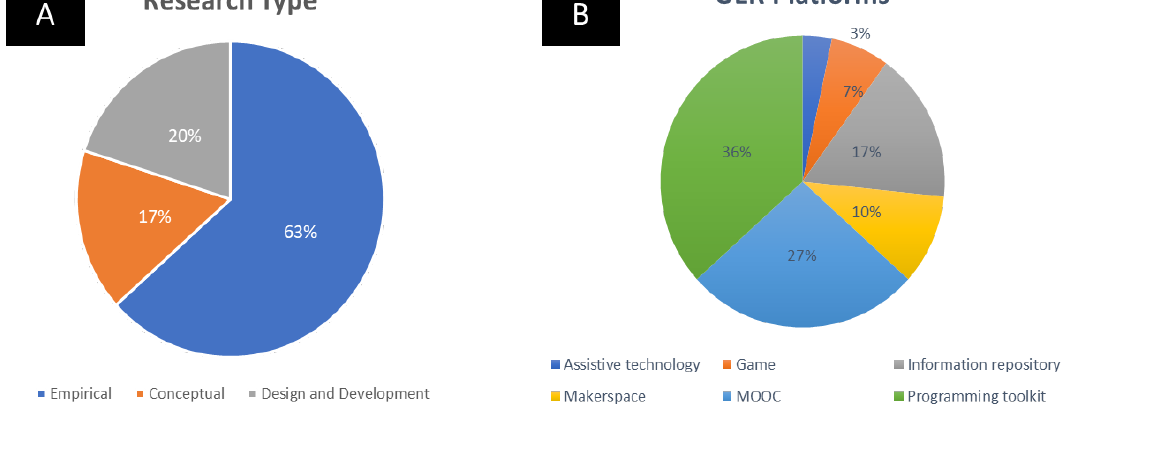
Note. Panel A: Research types. Panel B: OER